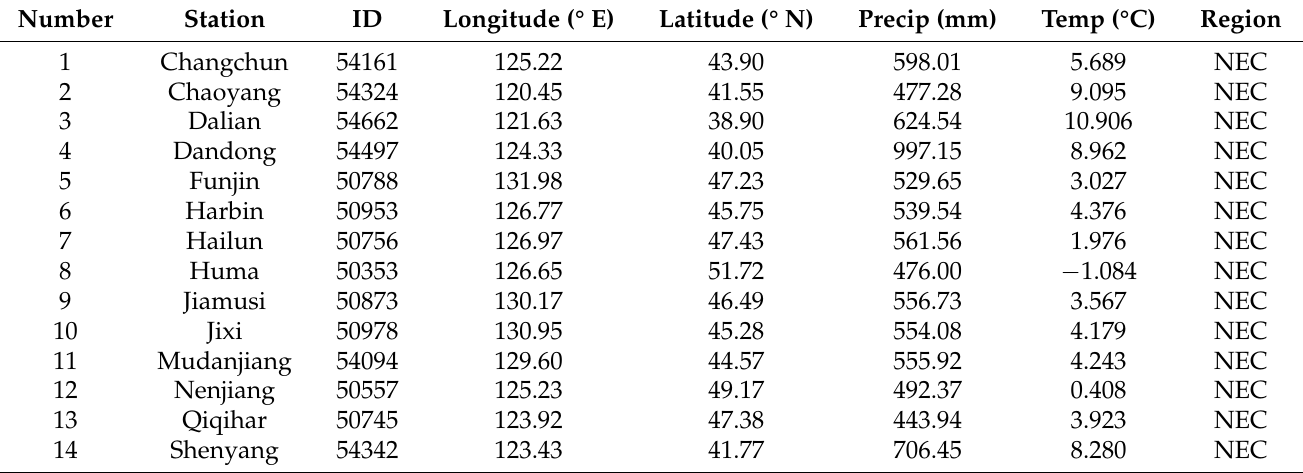
Table A1. The longitude/latitude and climatic descriptive statistics of 160 meteorological stations over